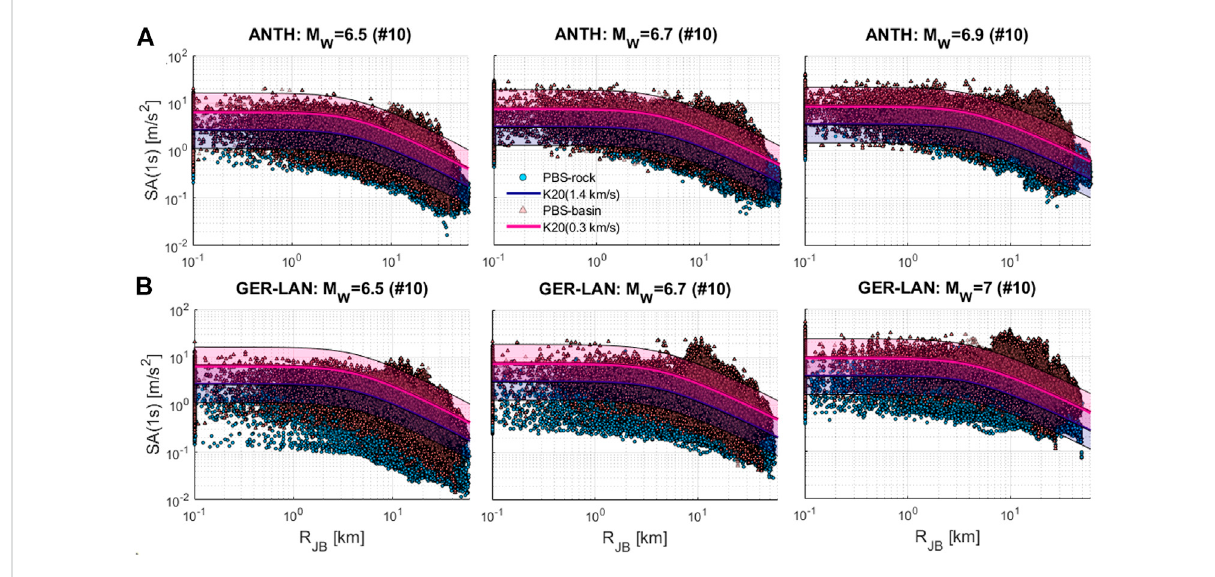
FIGURE 13 Comparison of simulated SA (1 s) as a function of distance (R JB ) with K20 at both rock (blue) and basin (magenta) sites for all earthquake scenarios considered in this work: (A) ANTH with M W =6.5 (left), 6.7 (center), 6.9 (right) and (B) GER-LAN fault with M W =6.5 (left), 6.7 (center), 7.0